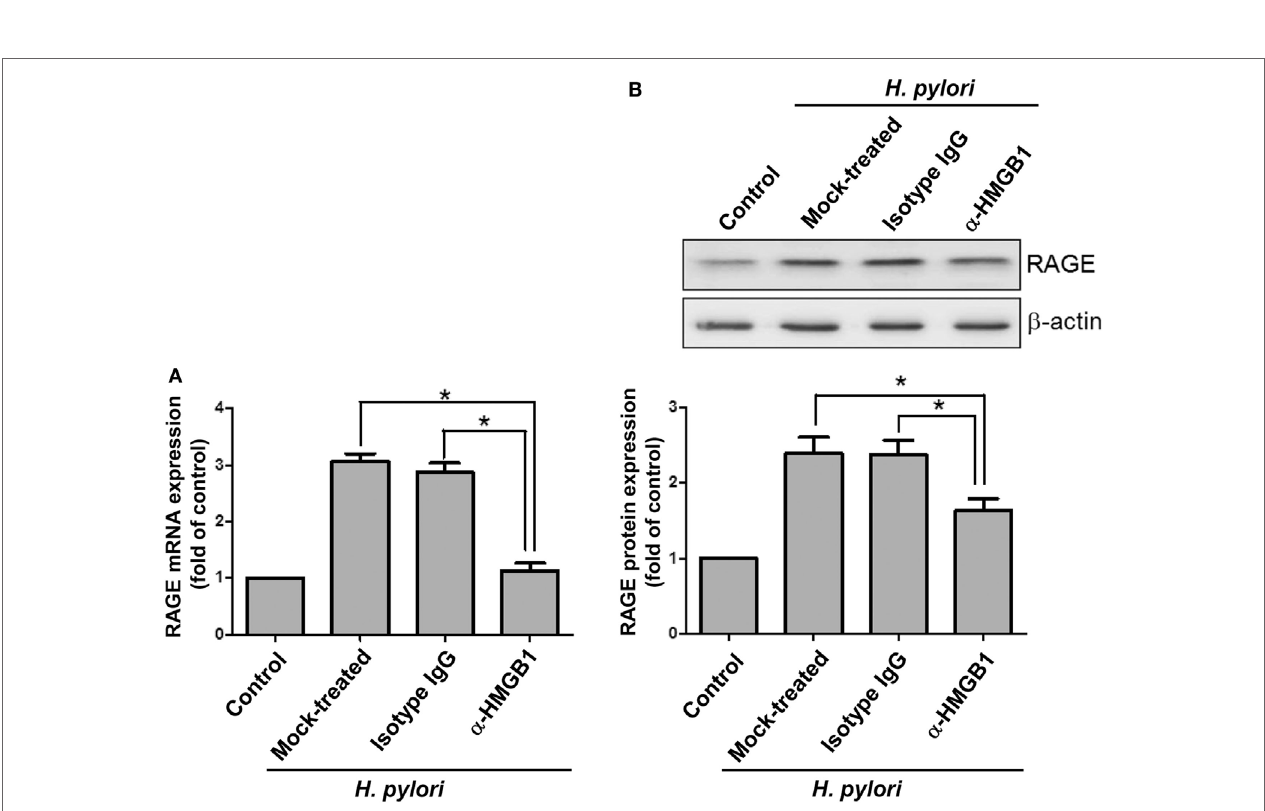
FigUre 4 | hMgB1 is crucial for rage expression in H. pylori -infected cells . AGS cells were untreated or pretreated with 1 μ g/ml of isotype IgG or anti-HMGB1 at 37°C for 30 min and then infected with H. pylori at an MOI of 100 for 6 h. RAGE mRNA and protein expression levels were measured by (a) quantitative real-time PCR and (B) Western blot analysis, respectively. Results are expressed as means ± SDs. * P < 0.05.